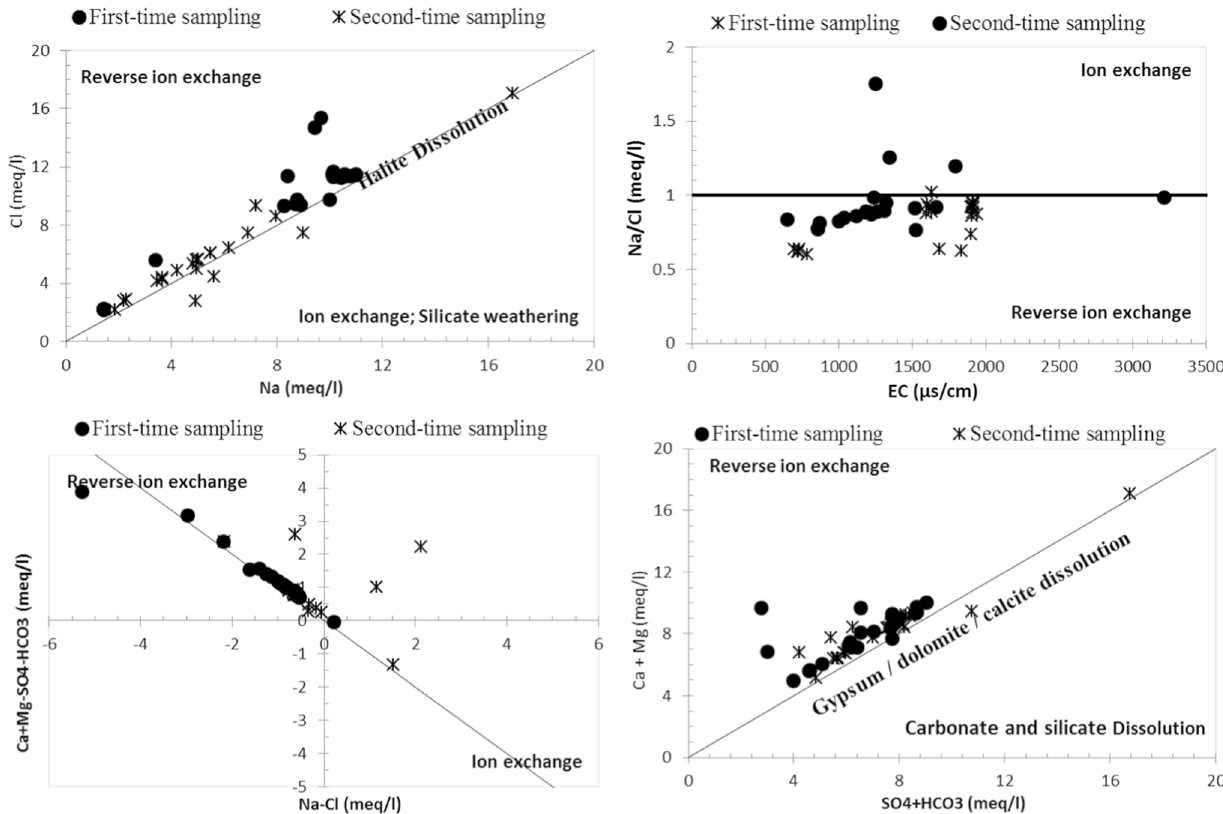
Fig. 3 Result of the reverse ion exchange diagrams for the Karun River in the lake and downstream of the Gotvand-e-Olya